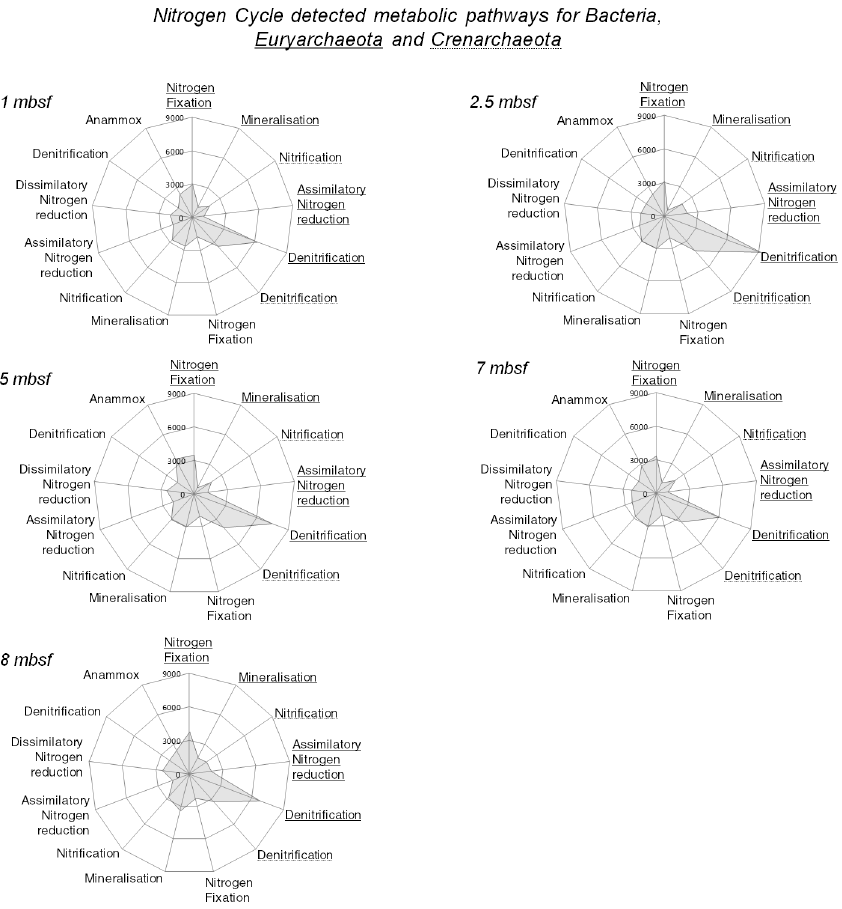
Figure 5. Nitrogen-cycling metabolic pathways identified at different depths for BCK1 sediment cores. Bacterial metabolic pathways are not underlined while Euryarchaeota and Crenarchaeota -related pathways are underlined with solid and dotted line respectively. Relative signal intensity was normalized by the number of the probes for each indicated metabolic pathway. List of targeted genes for each category are provided in Table S2.